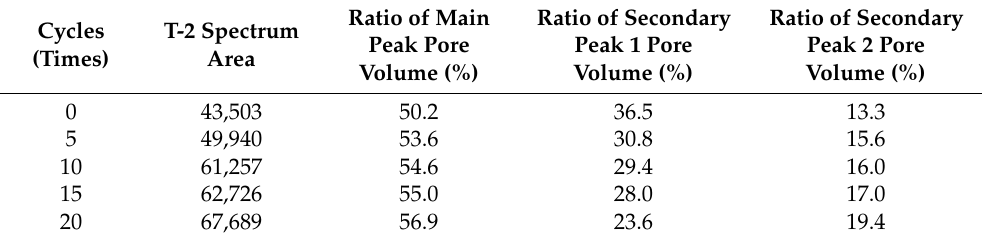
Table 6. Variations in the ratio of pore volume to each peak in coarse-grained soil T-2 curve.